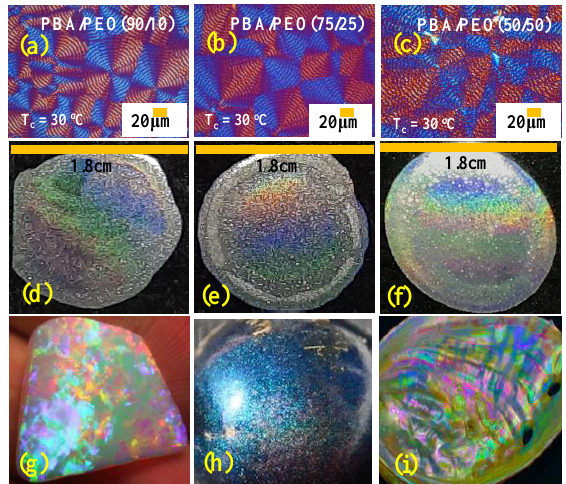
Figure 12. ( a – c ) POM micrographs, ( d – f ) photonic iridescence from ring-banded PBA (T c = 30 °C) crystallized from PBA/PEO blend of three compositions: 90/10, 75/25, 50/50, ( g ) opal [48], ( h ) Pollia berry [49], ( i ) nacre/abalone shell (self-photo work).